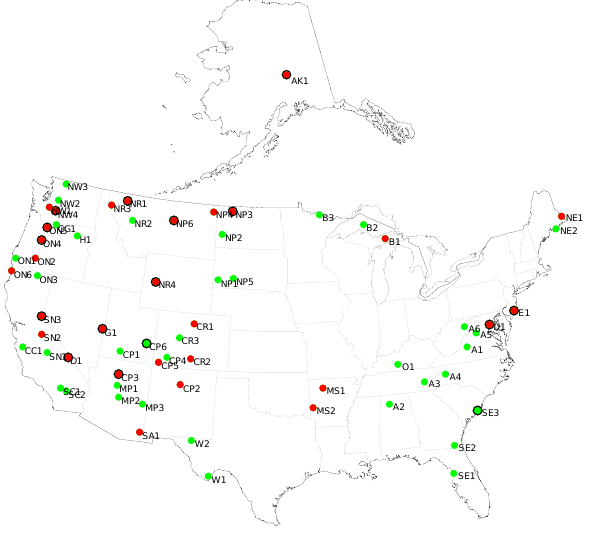
2 Figure 3. Fig. 3. Sixty-five IMPROVE sites in 25 regions (see Table 1 for def- initions). Color codes indicate the changes of EC- τ R regression co- efficients across the instrumental upgrade in 2005. Red: significant change in slope ( p < 0 . 05); solid edge: significant change in inter- cept ( p < 0 . 05); green: all other sites without significant changes. See text for details.